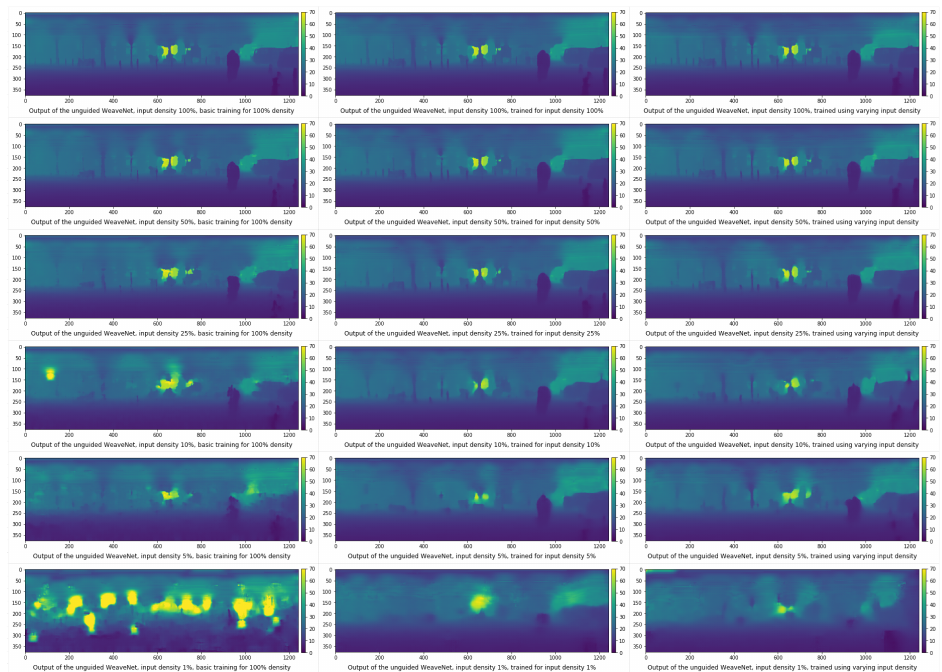
Figure 8. Output of the unguided WeaveNet for various densities for different training modes (basic training on the left, training for specific density in the middle, training for variable density on the